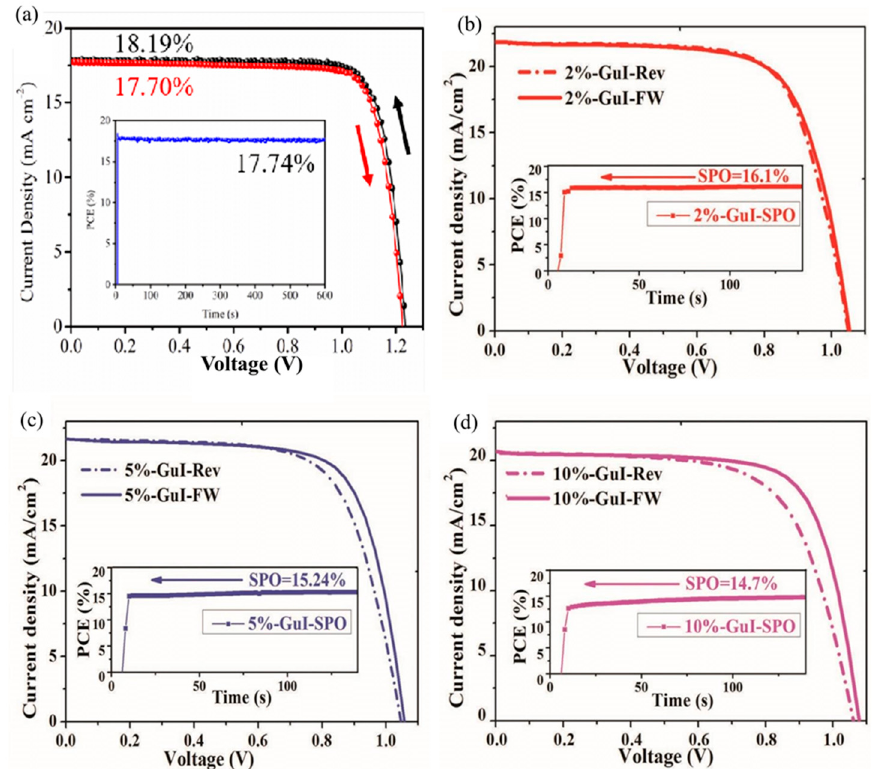
Figure 8. ( a ) J–V curves of the device with GABr treatment under different scans. The inset is the steady-state efficiency of the device (Reprinted with permission from Ref. [307]. Copyright: